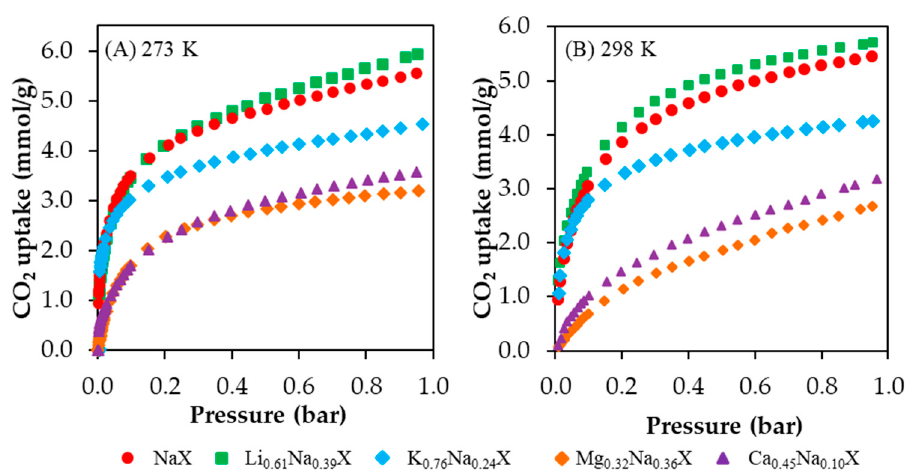
Figure 7. CO 2 adsorption isotherms at 273 K ( A ) and 298 K ( B ) of cation exchanged samples. Figure 8 presents the correlations of CO 2 uptake vs. micropore or submicropore vol- umes at 273 K and 298 K. As the CO 2 uptake is negligible for non-porous materials, the linear equation has only one parameter, i.e., slope. In all cases, the R 2 parameter is above 0.9, which may indicate a high impact of the pore volume on the CO 2 uptake. One should notice that in case of submicropores, the slope has a higher value compared to impact. This indicates that submicropores are crucial for CO 2 sorption, which is supported by other studies [30–32].